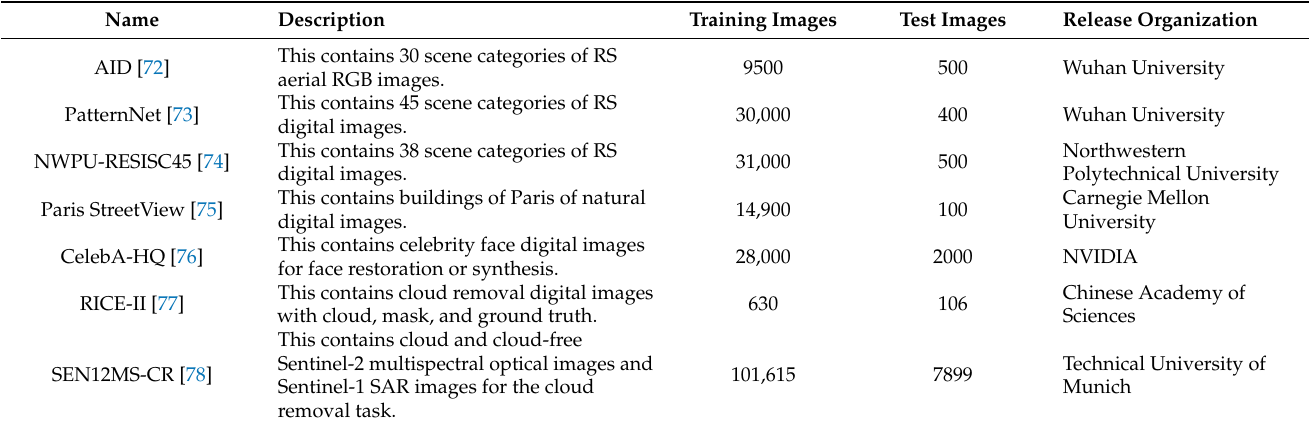
Table 2. The main experimental